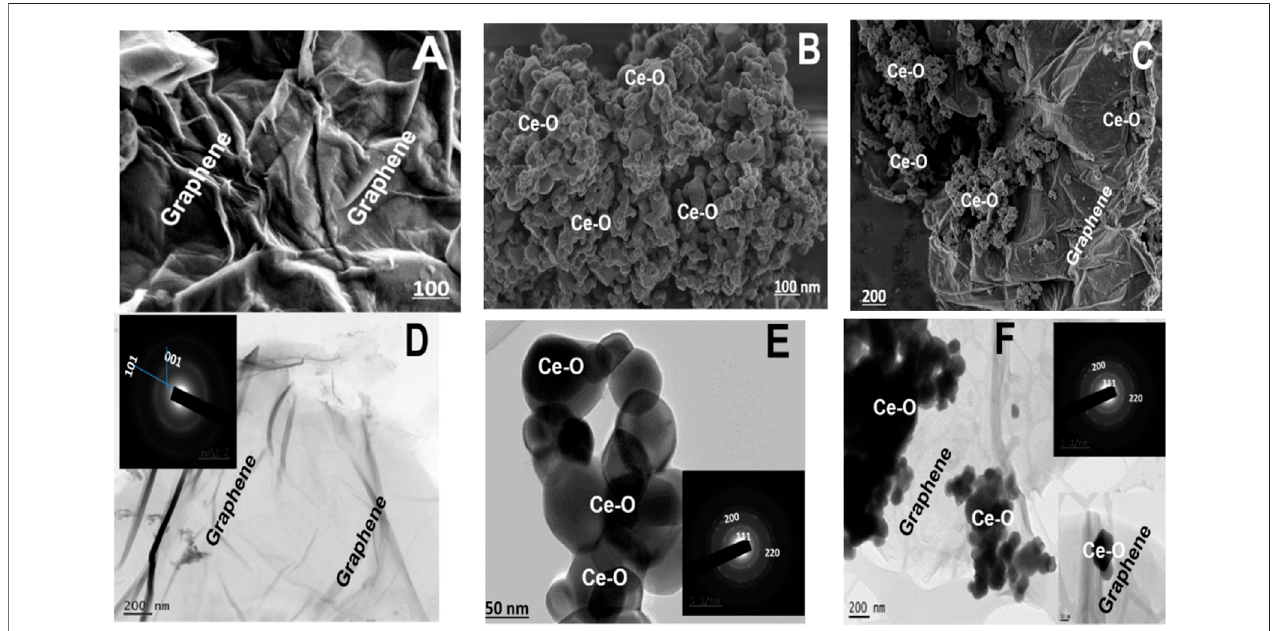
FIGURE 2 | (A – C) FESEM images, (D – F) TEM, and an inset image of SAED patterns for NGO, CeO 2 , and CeO 2 -NGO.